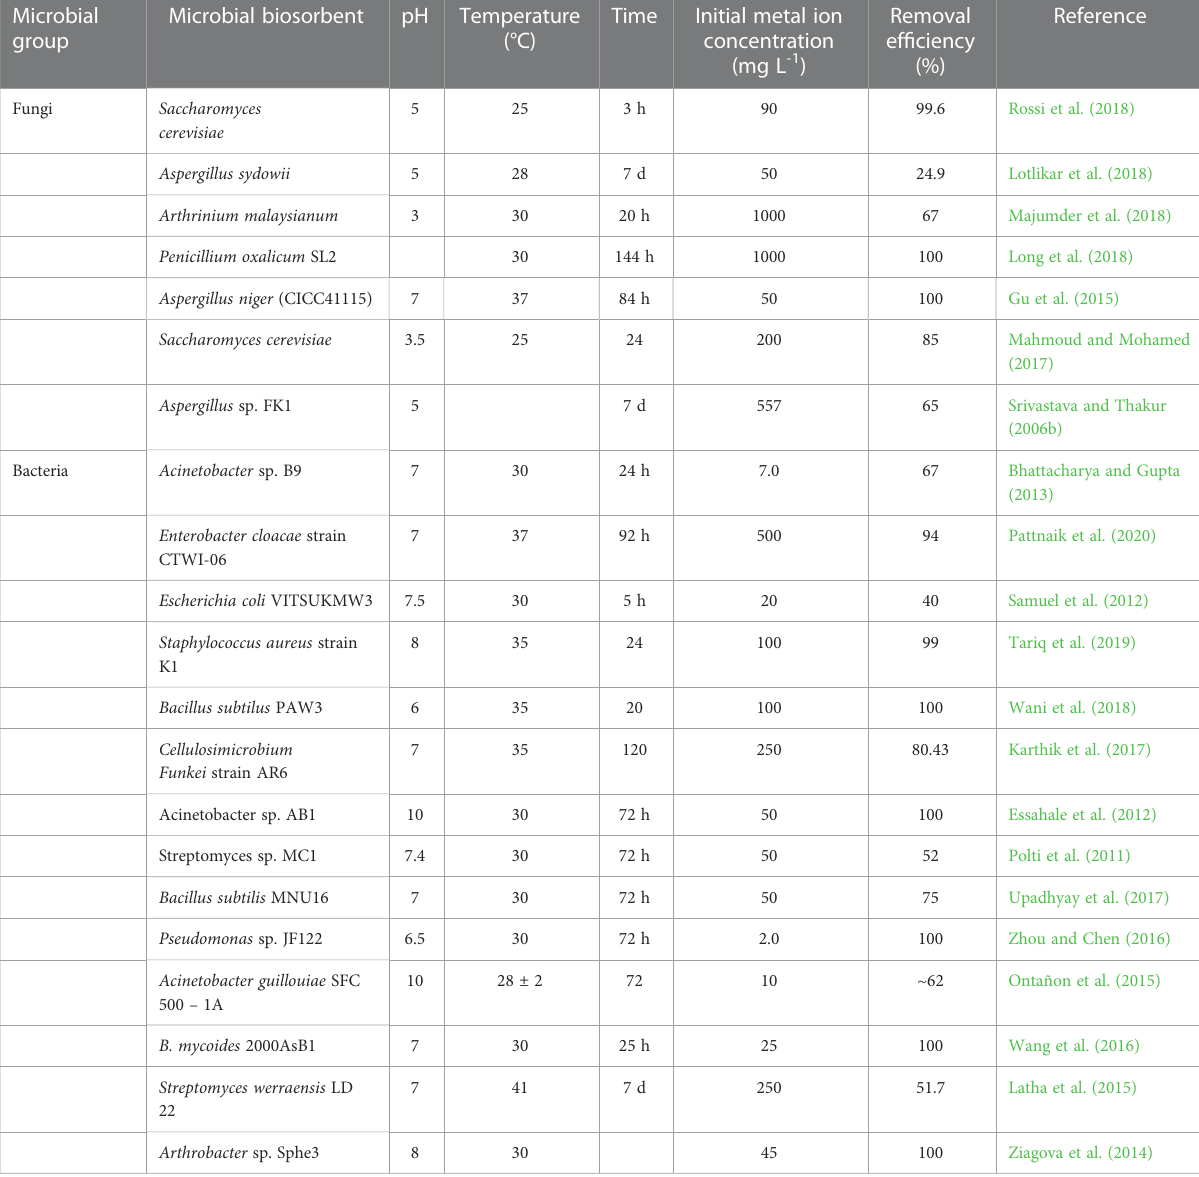
TABLE 3 Biosorption of chromium by application of different